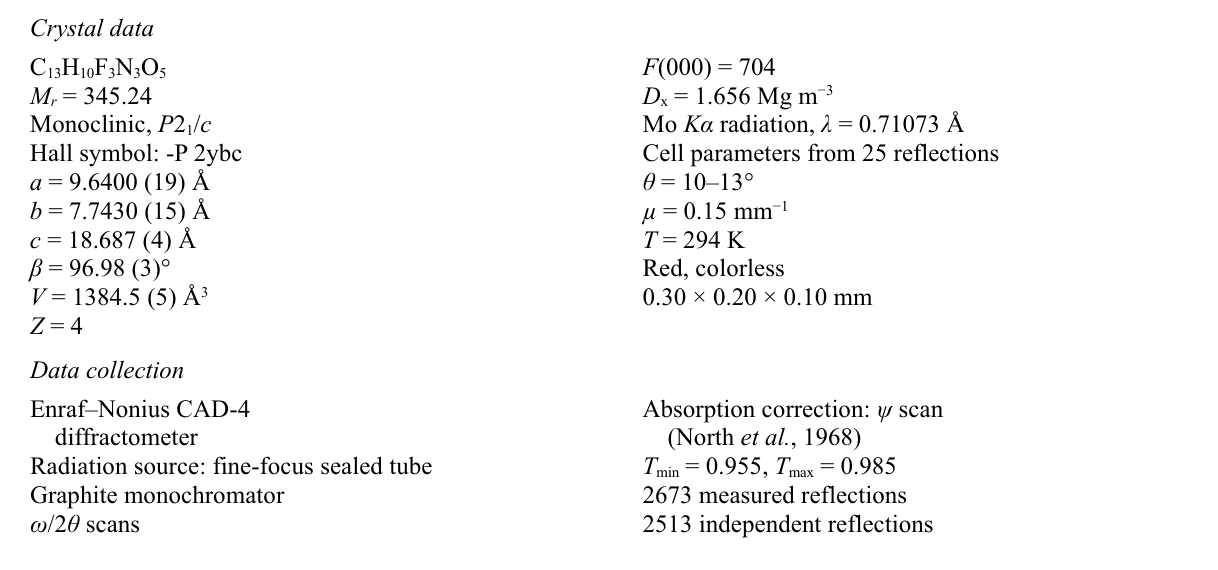
A partial packing diagram of the title compound. Hydrogen bonds are shown as dashed lines. 1-(4,5-Dinitro-10-azatricyclo[6.3.1.0 2,7